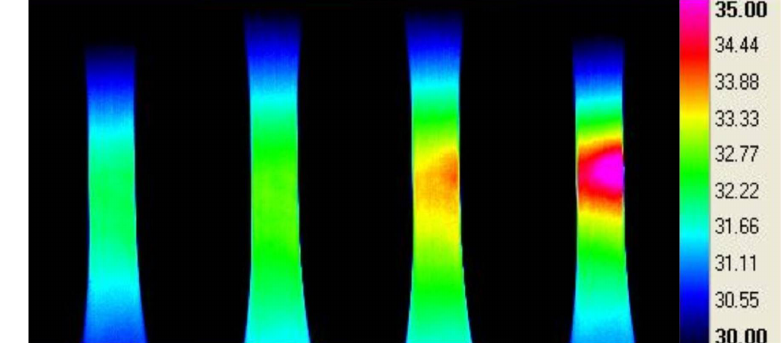
Figure 2: Hot-spot zone